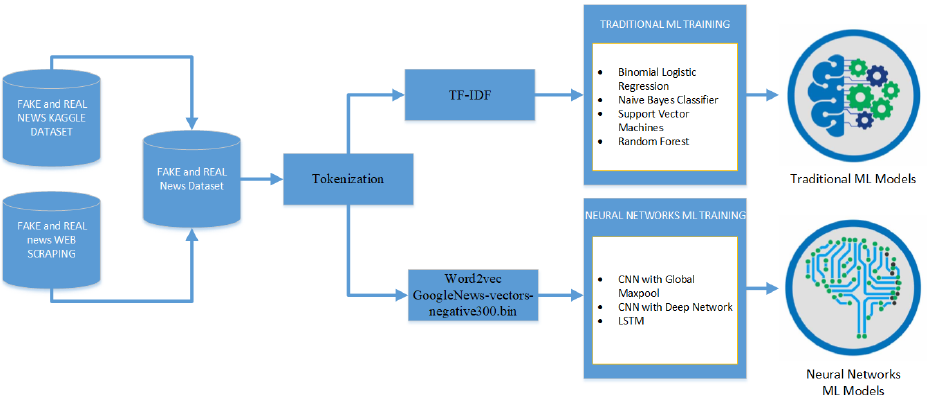
Figure 2. Workflows